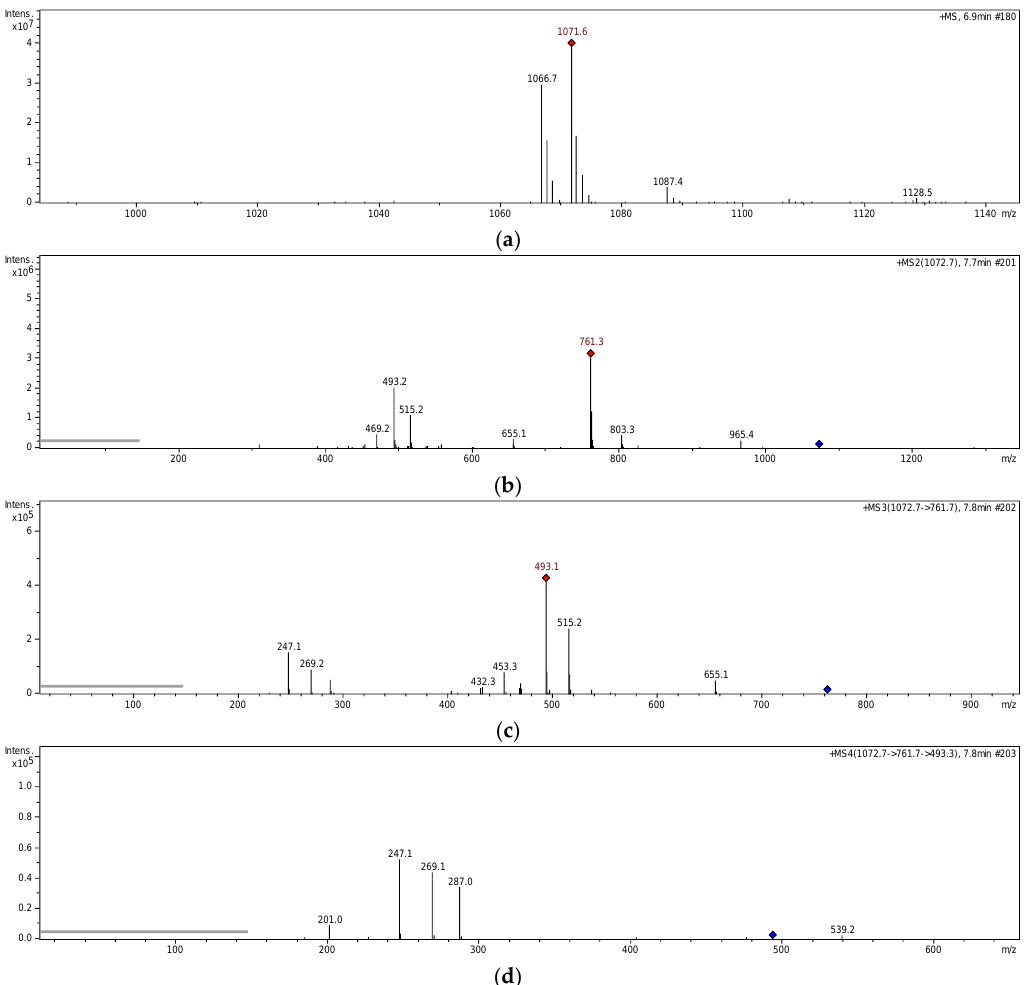
Figure 3. MS n spectra of compound 6 . ( a ) Full-scan MS 1 spectrum, ( b ) ESI-MS 2 spectrum, ( c ) ESI-MS 3 spectrum, ( d ) ESI-MS 4